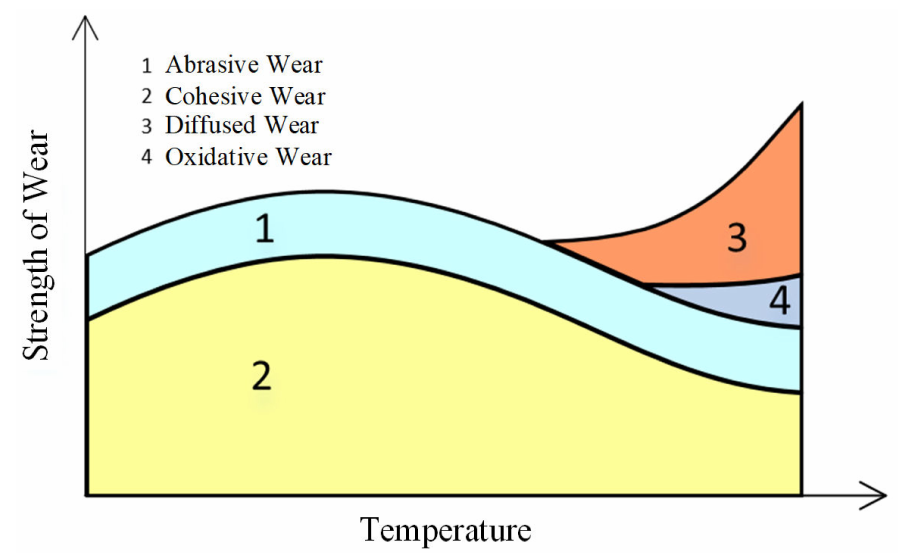
Figure 6. Relationship between tool abrasion mechanism and